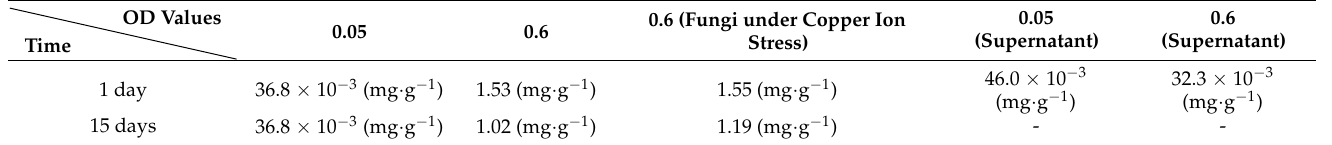
Table 3. The cu ion content in the culture supernatant and cells of Y. lipolytica after treatment.